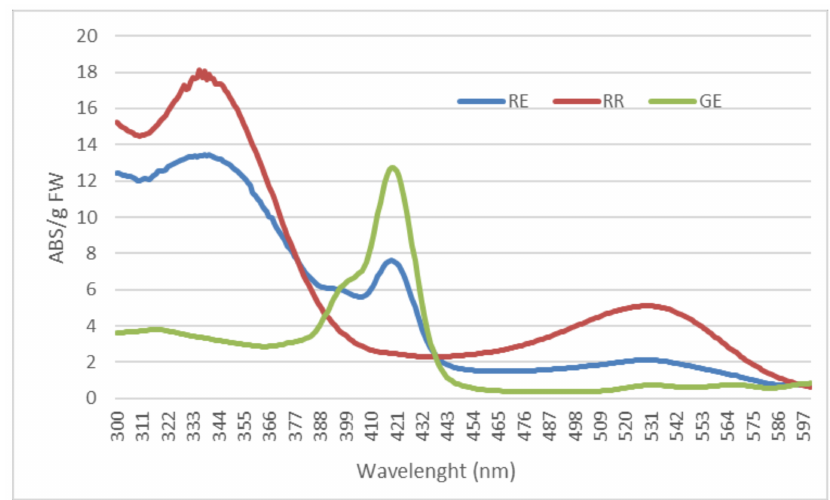
Figure 2. Comparison between UV-Vis absorbance spectra of methanolic extracts of the different varieties. Data points are means ( n = 4).